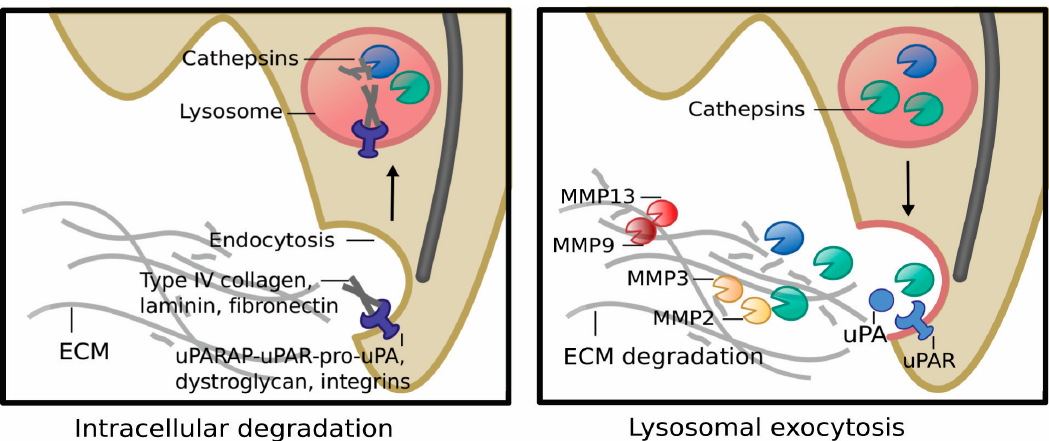
Figure 4. Graphical presentation of cellular mechanisms activated in lysosome-mediated invasion. Peripheral lysosomes contribute to extracellular matrix (ECM) degradation both internally ( left ) and externally ( right ). Peripheral lysosomes degrade the ECM components that have been internalized by the cell e.g., via endocytosis. Peripheral lysosomes can secrete their contents, including cathepsin B, into the extracellular space via lysosomal exocytosis, a process where the lysosome membrane fuses with the plasma membrane, which allows the secretion of the lysosomal contents to the extracellular space. Secreted cathepsin B degrades the ECM components: type IV collagen, laminin and fibronectin and initiates the activation of the extracellular degradome by cleaving the pro-forms of urokinase plasminogen activator and MMP2 and MMP3, which are activators of MMP9 and MMP13.